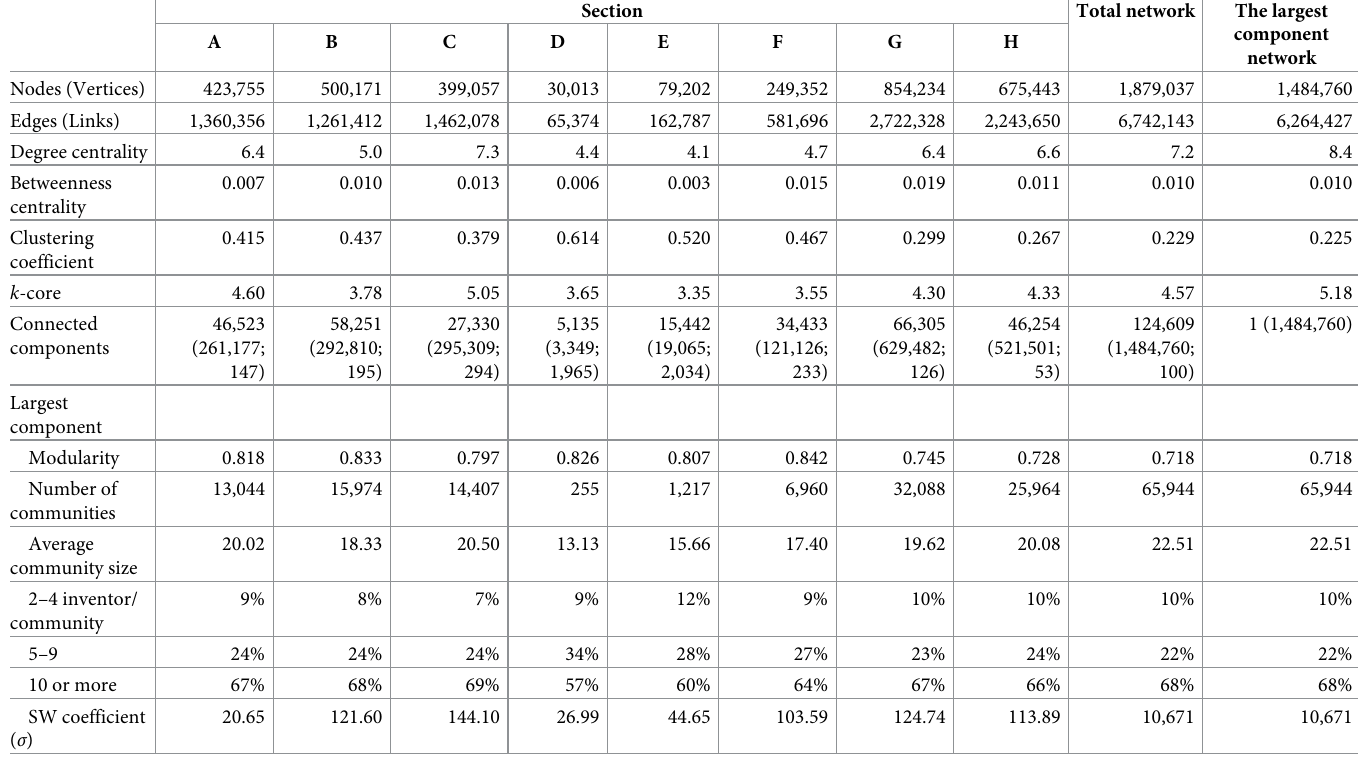
Table 1. Co-inventor network statistics by technological field (IPC) and total,